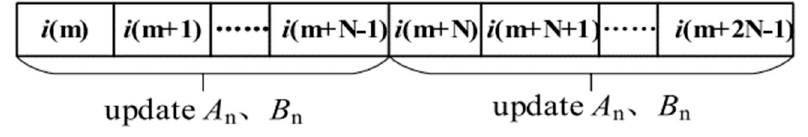
Figure 11. Data sampling cycle of the DWT method.